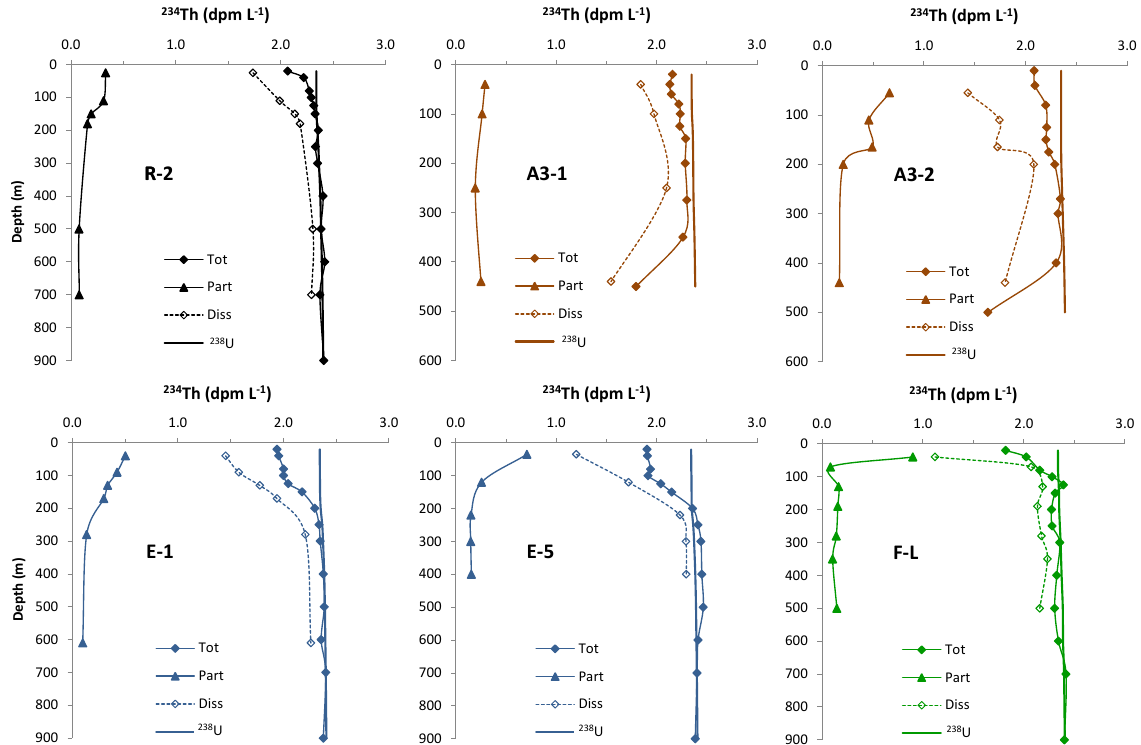
Figure 2. Depth profiles of total 234 Th ( 234 Th tot ), particulate 234 Th p (sum of the two size fractions), and dissolved 234 Th (total − particulate, − 1 ) along with 238 U activity (dpmL − 1 , solid lines) deduced from salinity at HNLC reference station R, central 234 Th d ) activity (dpmL plateau station A3 (A3-1, first visit 20 October; A3-2, second visit 16 November), PF meander station E (E-1, first visit 30 October; E-5, fourth visit 8 November), and north of PF station